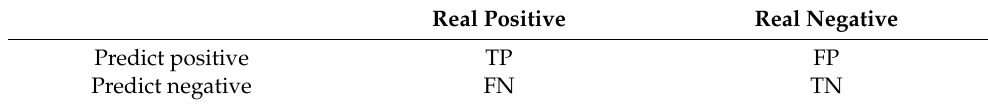
Table 1. Binary confusion matrix.